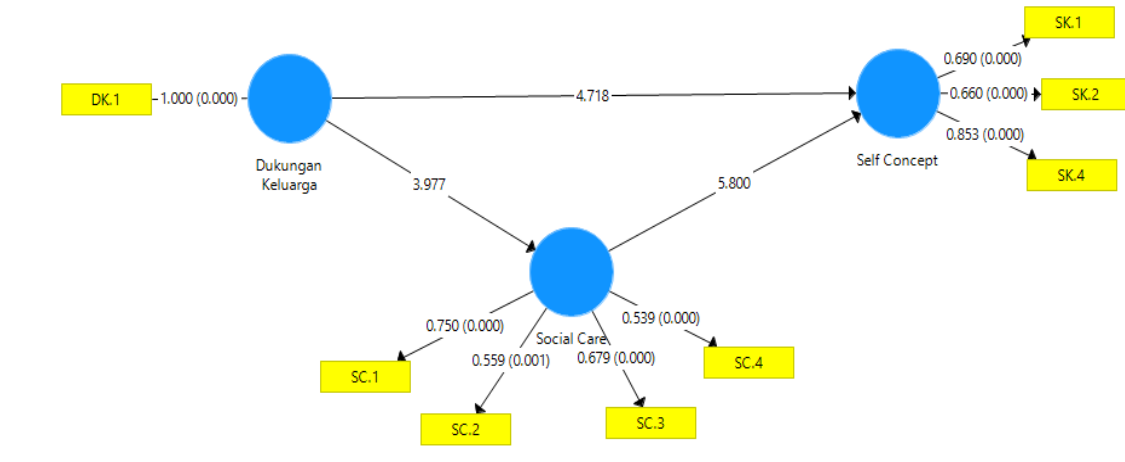
Figure 2. Test result model after